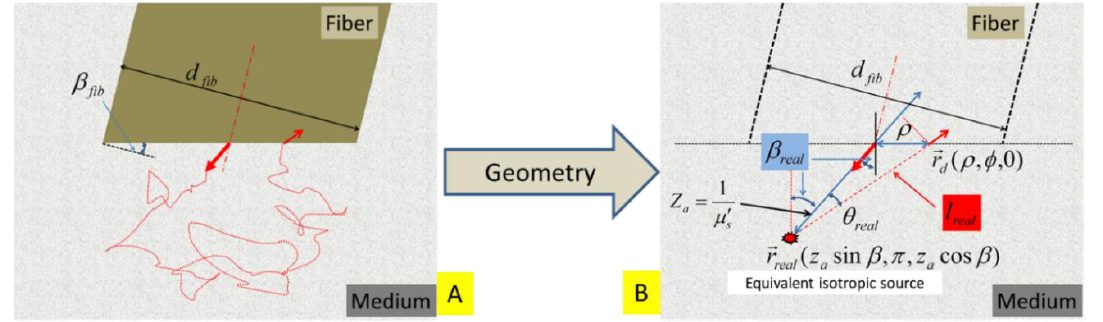
Figure 4. ( A ) Schematic of an idealized geometry for placing a fiber with a diameter of and an angle-polished tip within a turbid medium. The same fiber is used for launching light into and collecting light from the medium. A dual-point configuration approximates the light leaving and returning to the fiber. ( B ) The light that is directionally-launched into the medium along the fiber axis within the fiber refracts to an off-axis direction in the medium. As a result, the equivalent isotropic point source is located at an off-axis position of